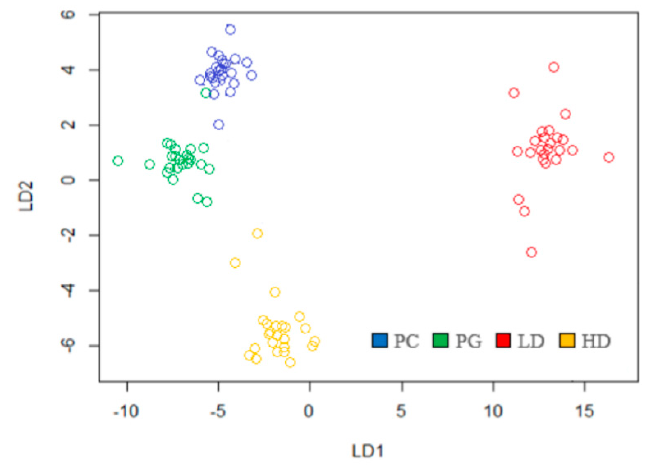
Figure 8. Two-dimensional linear discriminant analysis (LDA) of leaf reflectance for the four target species. PC (blue) = Psidium cattleianum ; PG (green) = Psidium guajava ; LD (red) = Luehea divaricata ; HD (yellow) = Hovenia dulcis .